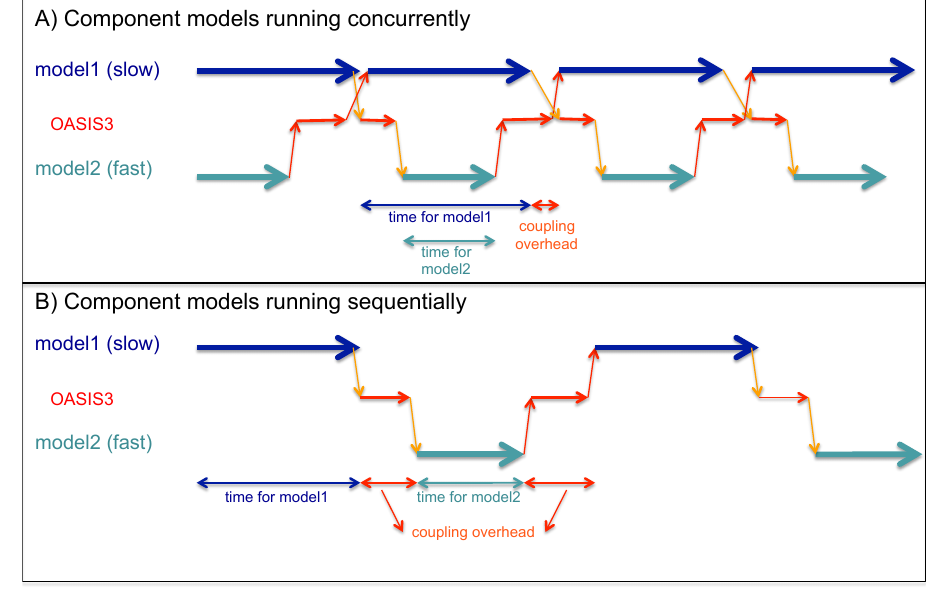
Fig. 4. Different coupling configurations and their impact on coupling overhead. In (A) the component models run concurrently and OASIS3 can perform its work when the fast model is waiting for the slow model; the coupling overhead (in elapse time) is, therefore, much smaller then in (B) where the component models run sequentially and where the coupling overhead is exactly the sum of the communication time and the OASIS3 time for the coupling exchanges in both